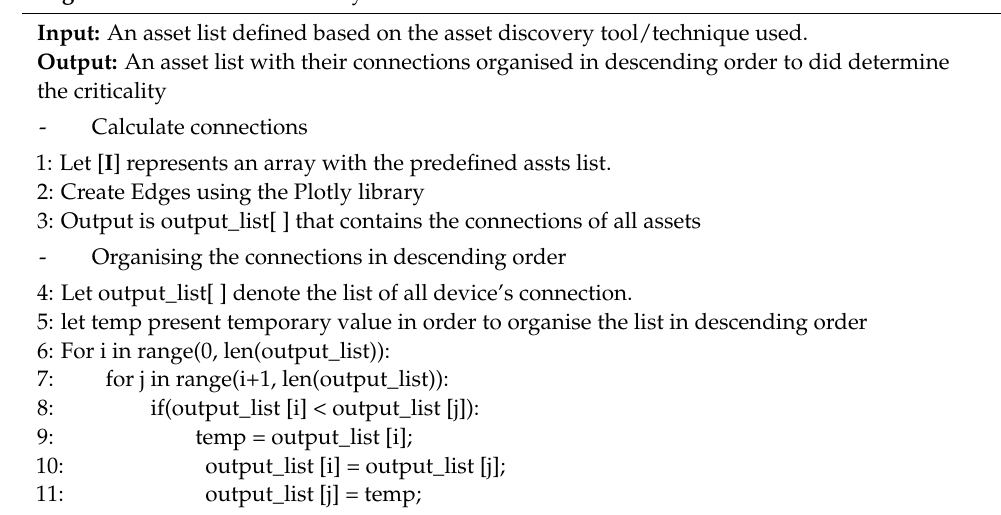
Algorithm 1 Calculate Criticality for ICS Asset